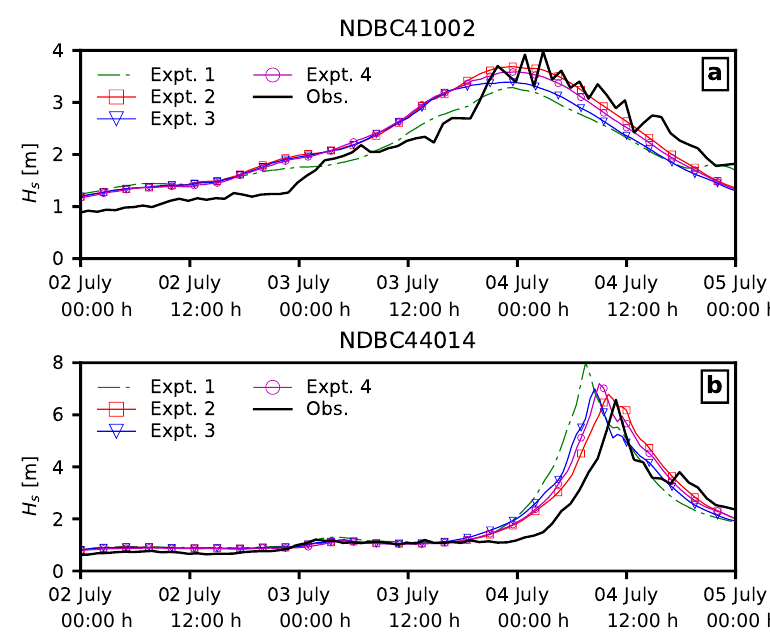
Figure 9. As in Fig. 7, but for significant wave height H s (m).